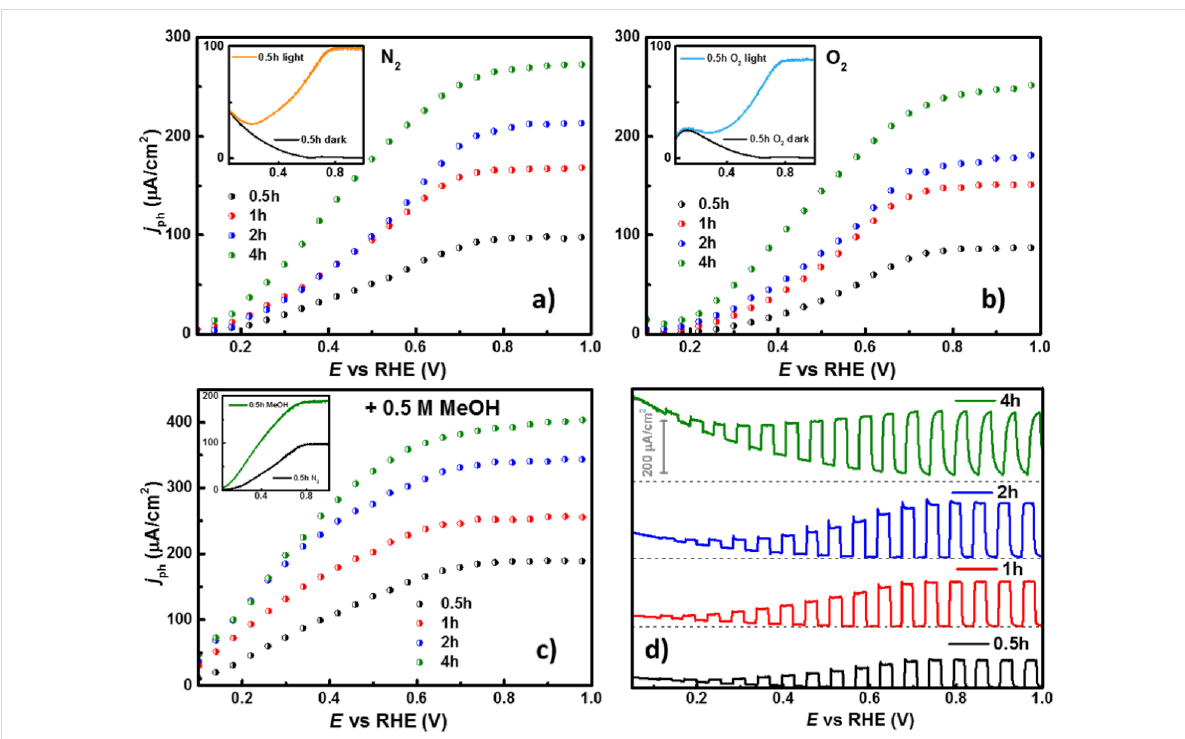
Figure 6: Extracted photo-current density, j ph , from potentiodynamic curves for the TNTs grown at different t a in (a) N 2 -saturated electrolyte, (b) O 2 -saturated electrolyte, with (c) 0.5 M MeOH. (d) On–off photocurrent transients for the same samples in N 2 -saturated electrolyte. Conditions: 0.5 M H 2 SO 4 , v = 5mV/s, and irradiation power = 20 mW/cm 2